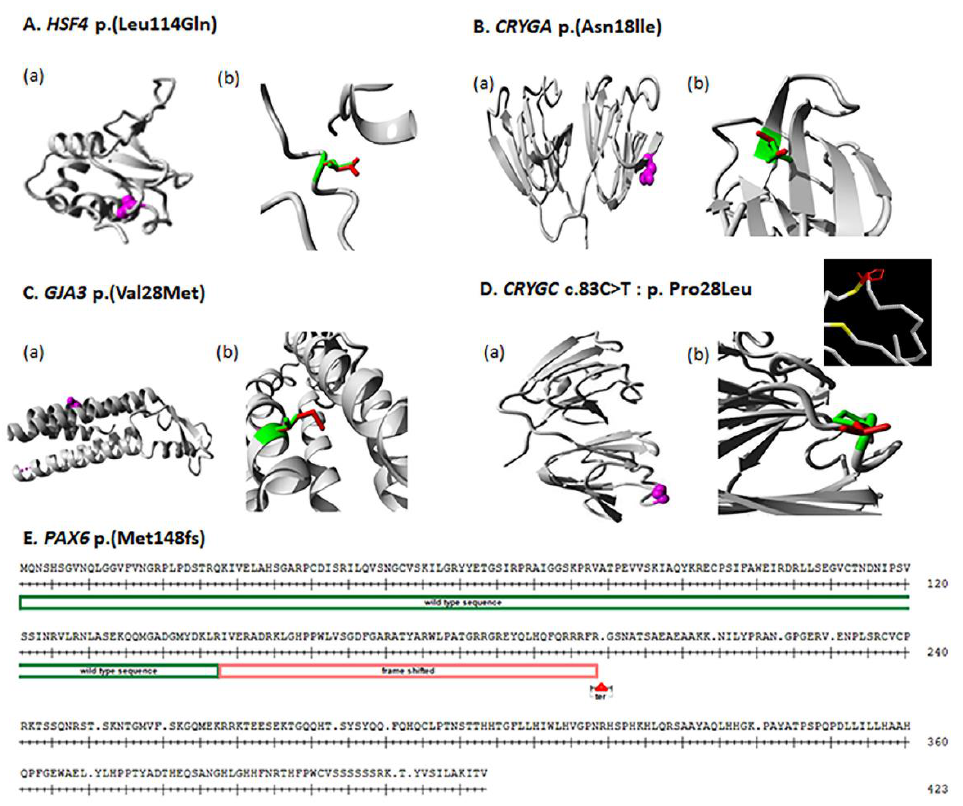
Figure 4. ( A – D ) Protein structure analysis for all detected variants by HOPE software. ( A – D ) ( a ): Each variant shows the position of amino acid in protein structure; the mutated residue is colored magenta. ( A – D ) ( b ): For each identified variant, enlarged views of both the wild-type and the mutant residue are shown and colored green and red, respectively. ( E ) Protein sequence of PAX6 gene, the red box indicates where the position of mutation started, resulting in a frame shift.